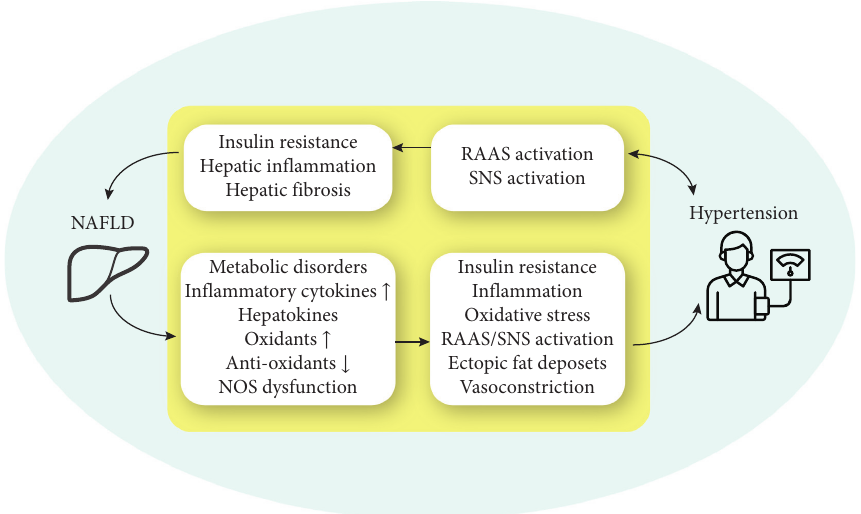
Figure 5: Putative mechanisms through which NAFLD may drive the development of HTN and vice